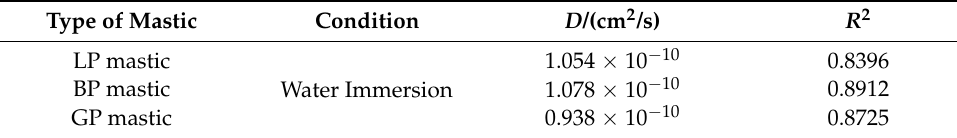
Table 8. Diffusion coefficient of water in different asphalt mastics. Type of